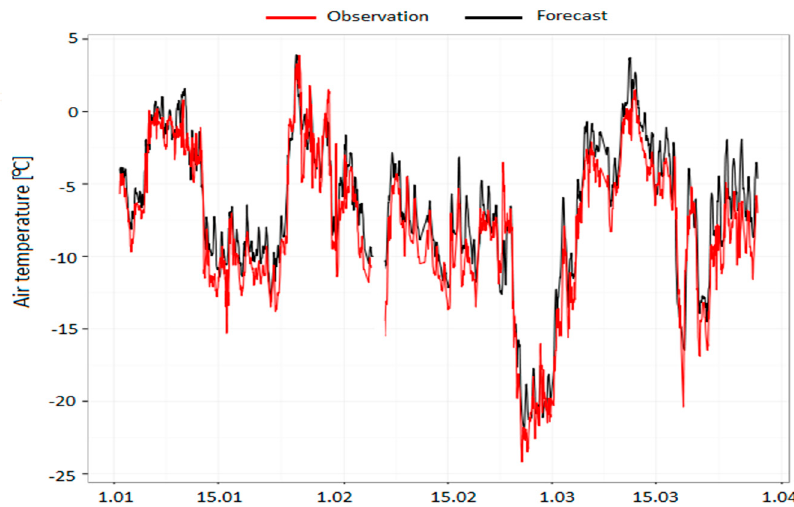
Figure 9. Measured and modeled values of air temperature (2 m above the ground) at Kasprowy Wierch station for the period 1 January to 30 April 2018 for AROME CMC 2 km.